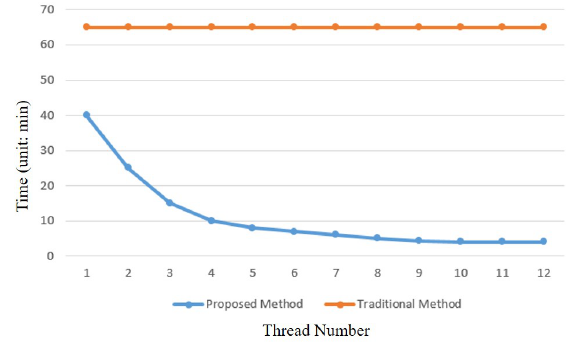
Figure 6 . Performance evaluation